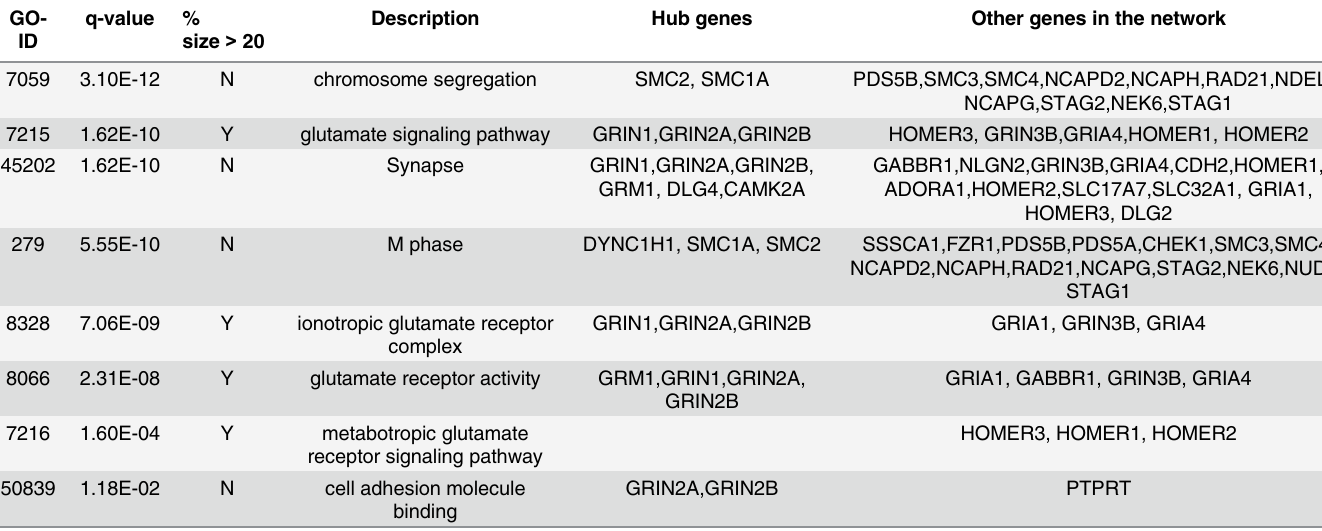
Table 7. GO enrichment analysis of stage-III network.